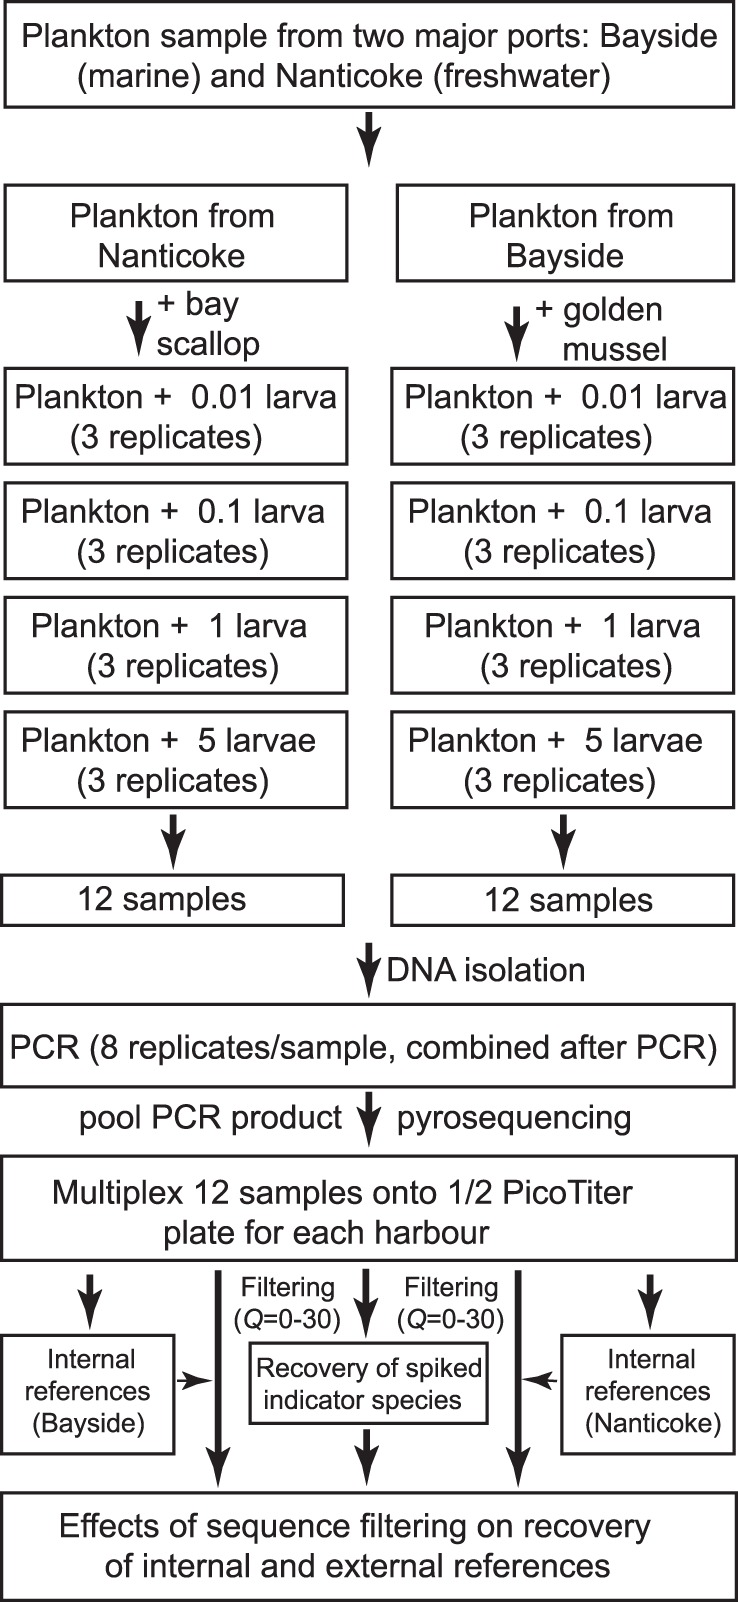
Methodological flow chart for setting up internal and external references for evaluating the influence of artifact removal on rare species detection in complex plankton communities using 454 pyrosequencing.